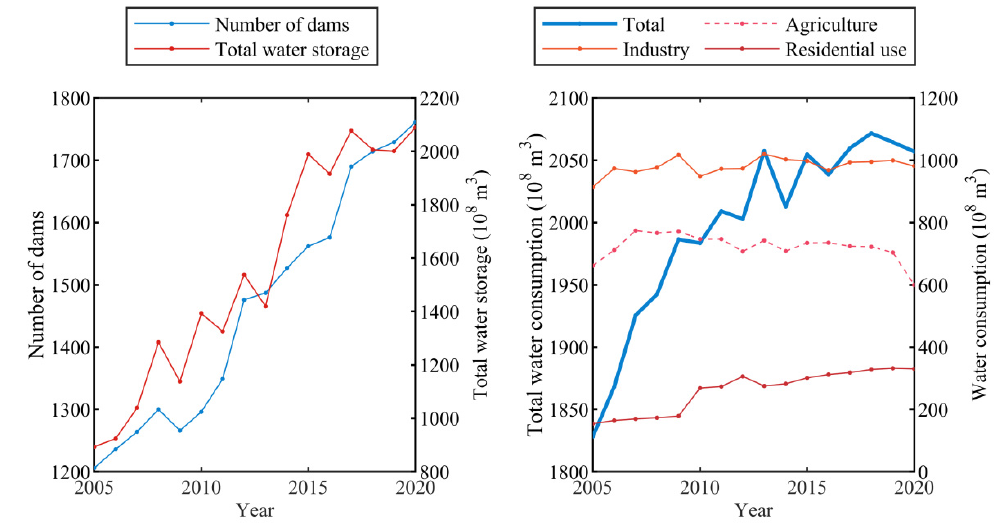
Figure 10. Variation of human activities before and after the year 2000.